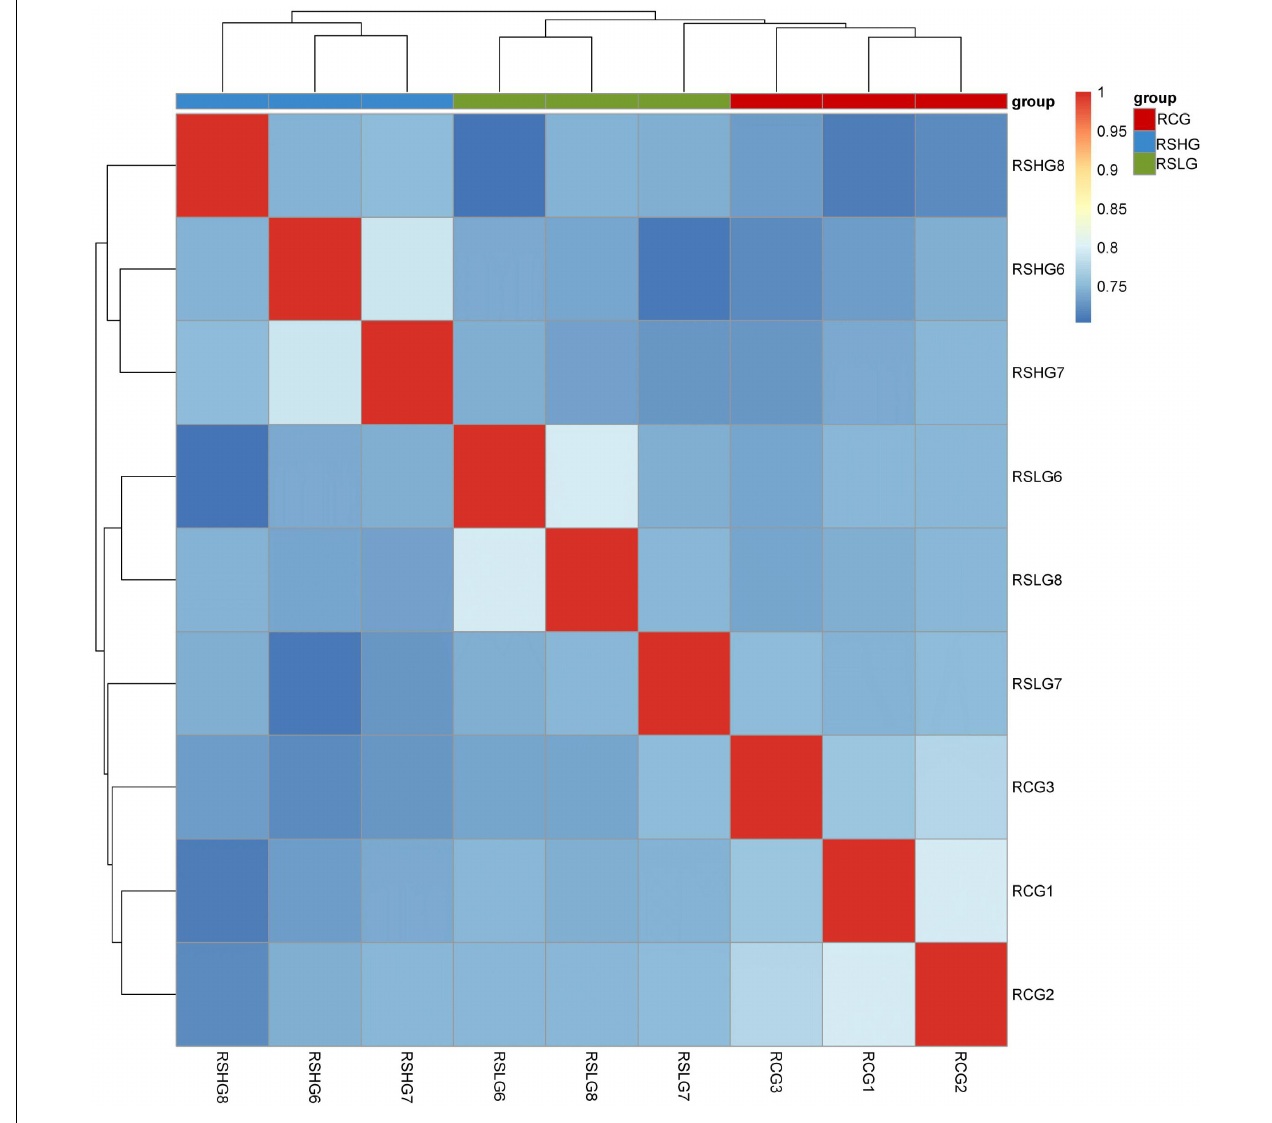
FIGURE 3 | Sample correlation heatmap of gene